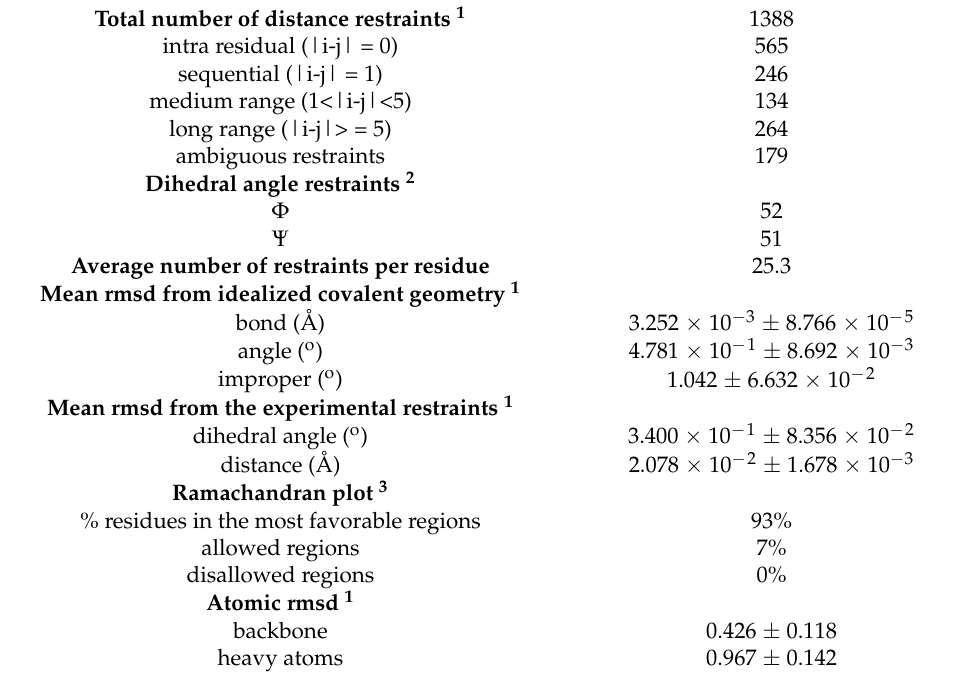
Table 1. Structural statistics for the ensemble of the 20 lowest energy structures of Sul7s in aqueous